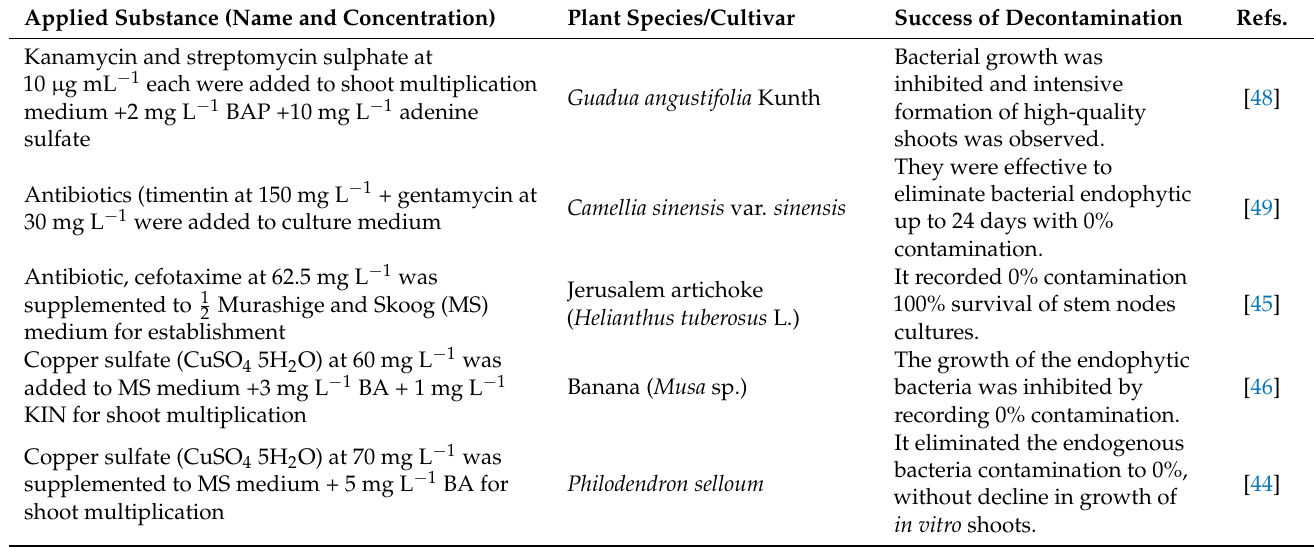
Table 2. Some antiseptic substances used for eliminating endophytic contamination in plant- tissue